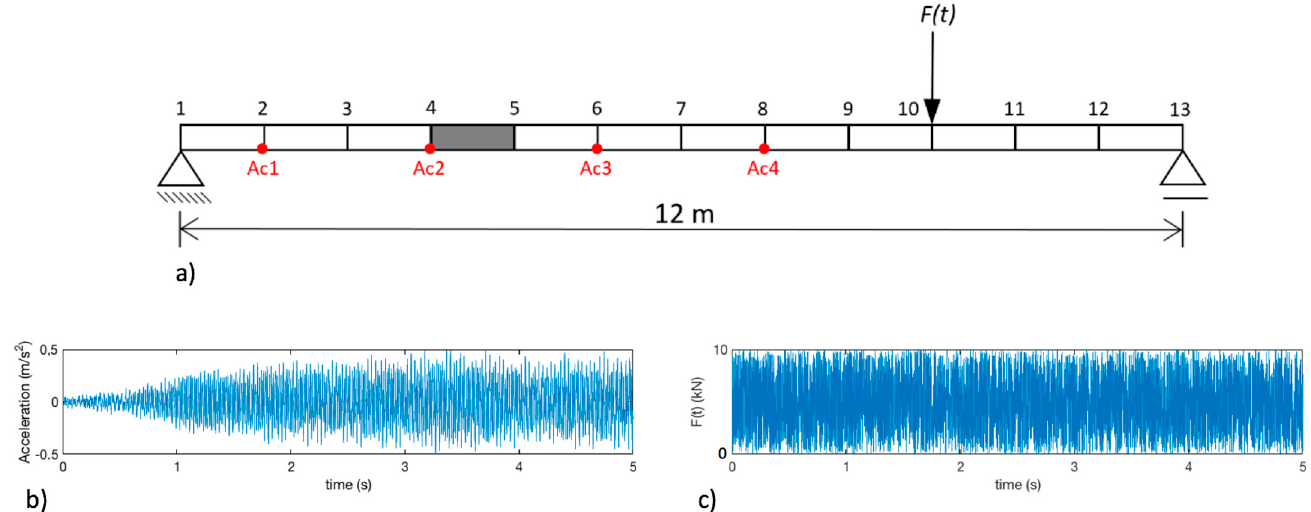
Figure 4. Numerical application—simply supported beam. ( a ) FEM model. ( b ) Typical numerical response. ( c ) Typical excitation force. Table 1. Variation of the numerical beam